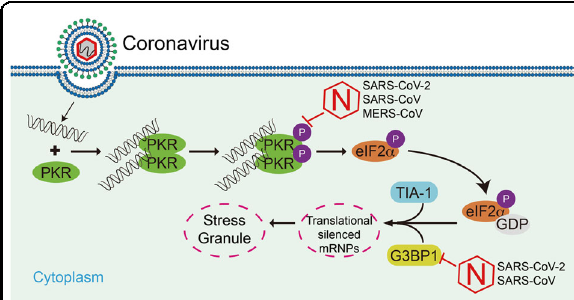
Fig. 6 A model on inhibition of SG formation by the NPs of coronaviruses. After coronavirus infection, the viral dsRNA binds to PKR, facilitating dimerization/oligomerization and autophosphorylation of PKR. The activated PKR catalyzes the phosphorylation of eIF2 α , leading to the recruitment of SG-nucleating proteins, such as TIA-1 and G3BP1, and eventually SGs assembly. The NPs of SARS-CoV-2, SARS-CoV, and MERS-CoV can inhibit PKR phosphorylation, leading to the impairment of SG formation. The NPs of SARS-CoV-2 and SARS-CoV, but not MERS-CoV can also sequester G3BP1 to impair G3BP1-mediated SG